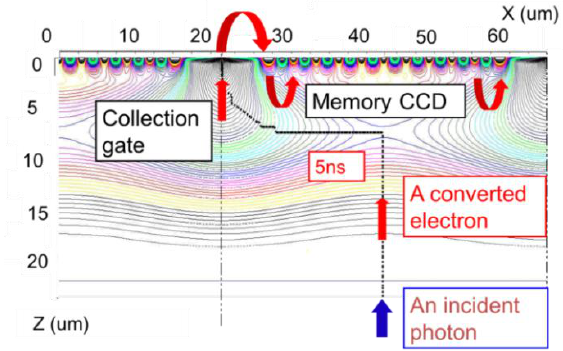
Figure 3. An example ptential profile and an electron path.